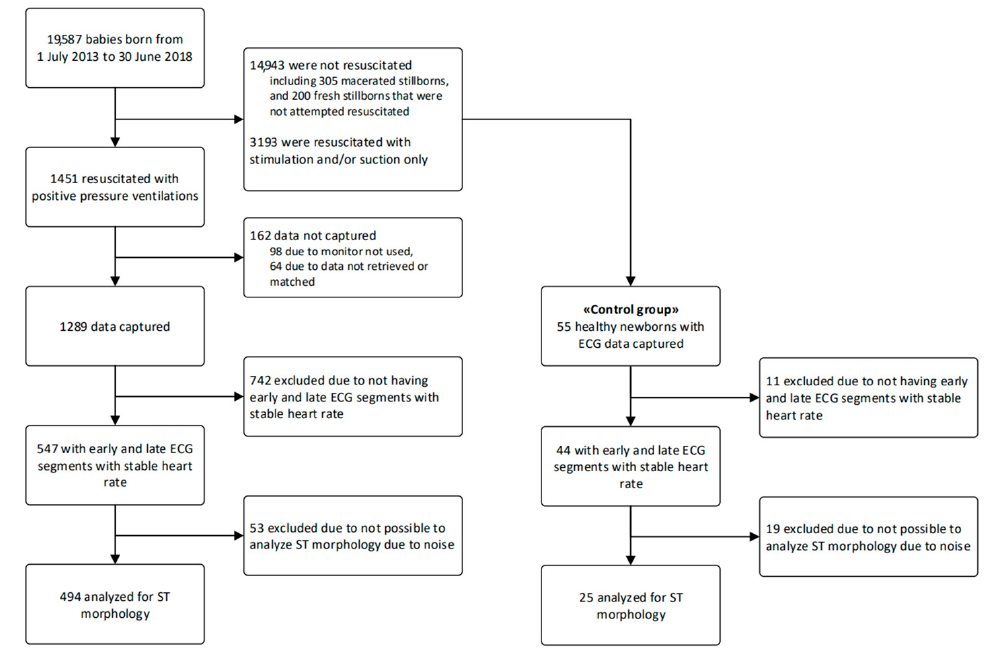
Figure 2. Flow diagram of inclusions.